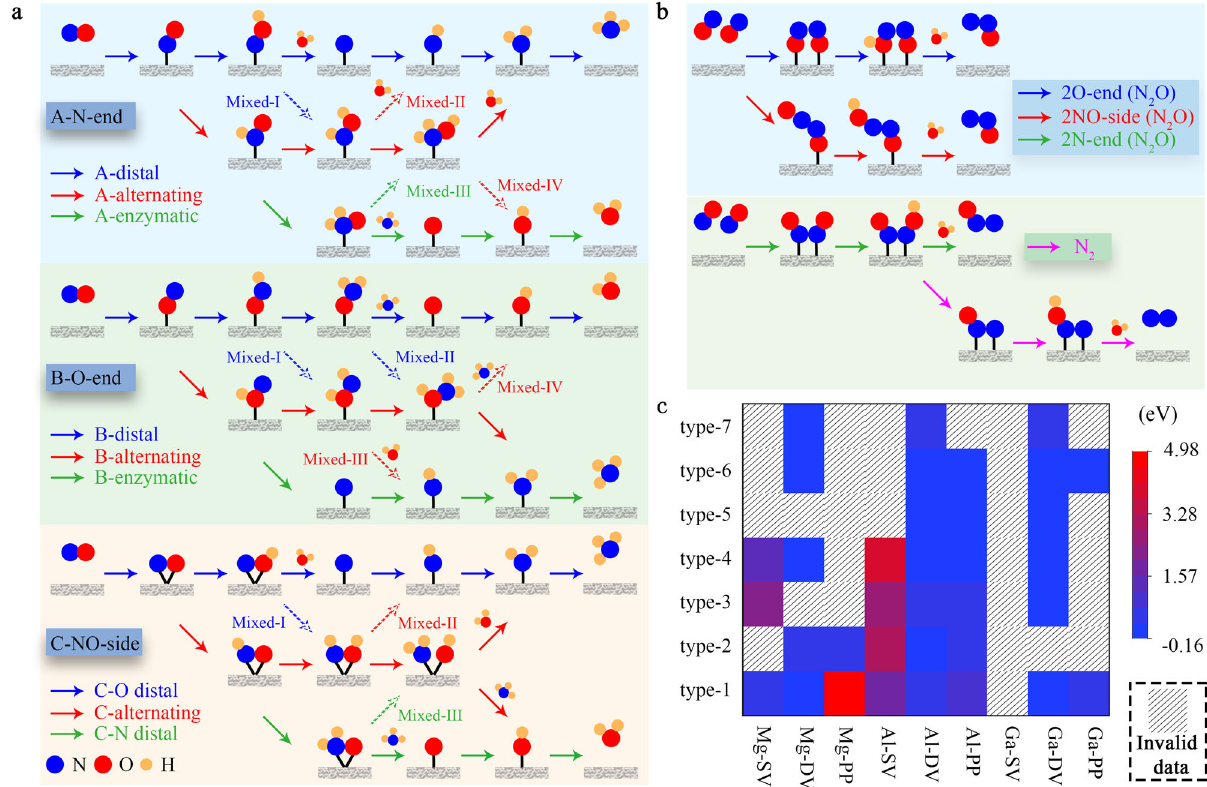
Fig. 3 Reaction mechanism and electrocatalytic activity of NORR on SAC candidates. a Schematic depiction of possible NORR pathways toward NH 3 synthesis. b Schematic depiction of possible NORR pathways toward N 2 O and N 2 synthesis. c Δ G max - NH3 on the remaining 35 SAC candidates via the corresponding most favorable reaction pathways. Type 1 to 6 in ( c ) is de fi ned in Supplementary Figs. 1 – 6.